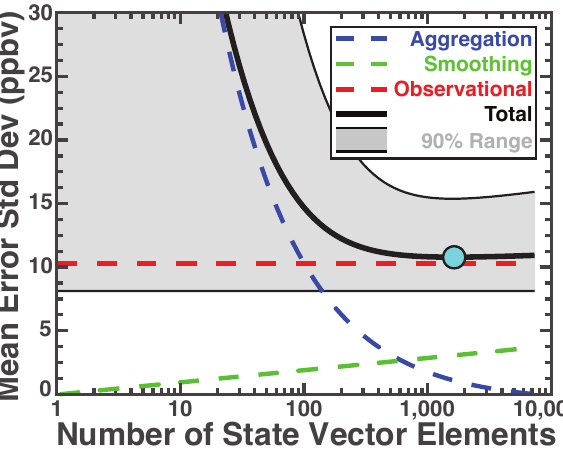
Figure 4. Total error budget from the aggregation of state vector el- ements in an inverse model. The application here is to an inversion of methane emissions over North America using satellite methane data with 7366 native-resolution state vector elements (Sect. 5 and Turner et al., 2015). Results are shown as the square roots of the means of the diagonal terms (mean error standard deviation) in the aggregation, smoothing, and observational error covariance matri- ces, and for the sum of these matrices. Aggregation uses the GMM with RBF weighting (Sect. 4). There is an optimum state vector size for which the total error is minimum and this is shown as the circle. Gray shading indicates the 90% range for the total error on individual elements as diagnosed from the 5th and 95th quantiles of diagonal elements in the total error covariance matrix. Note the log scale on the x